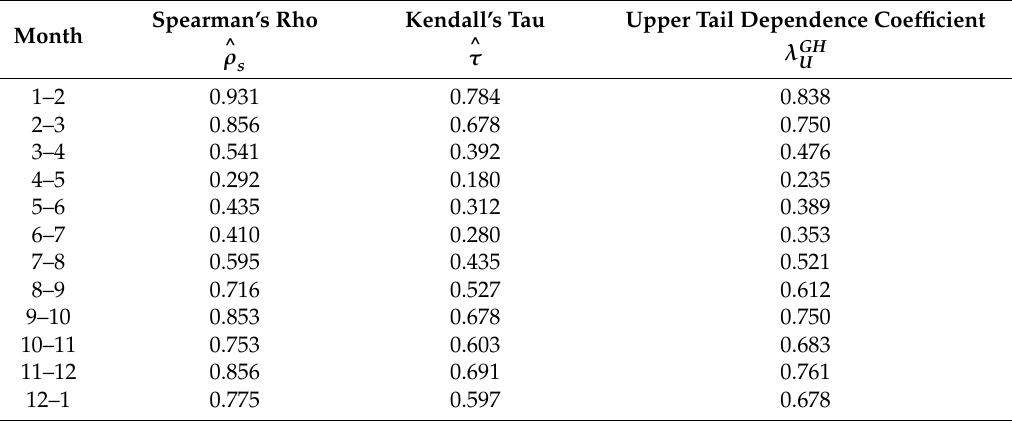
Table 5. Results of dependence